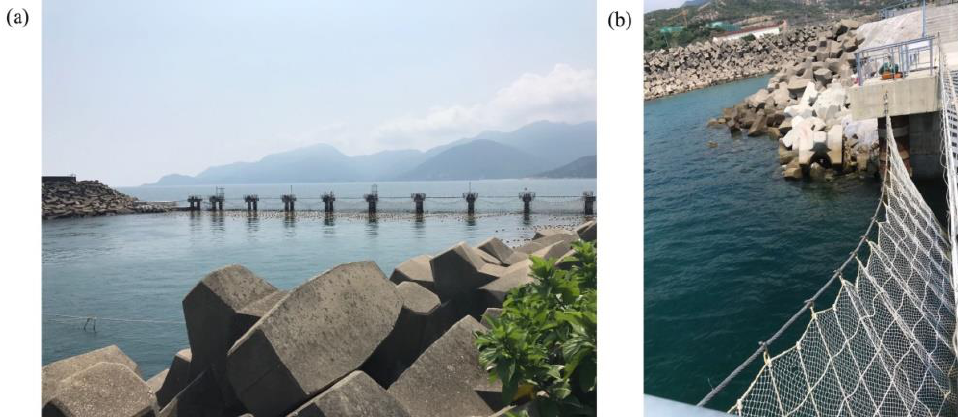
Figure 1. Trash-blocking nets attached at the pile foundations at the entrance of the open channel. ( a ) global view; ( b ) local view.